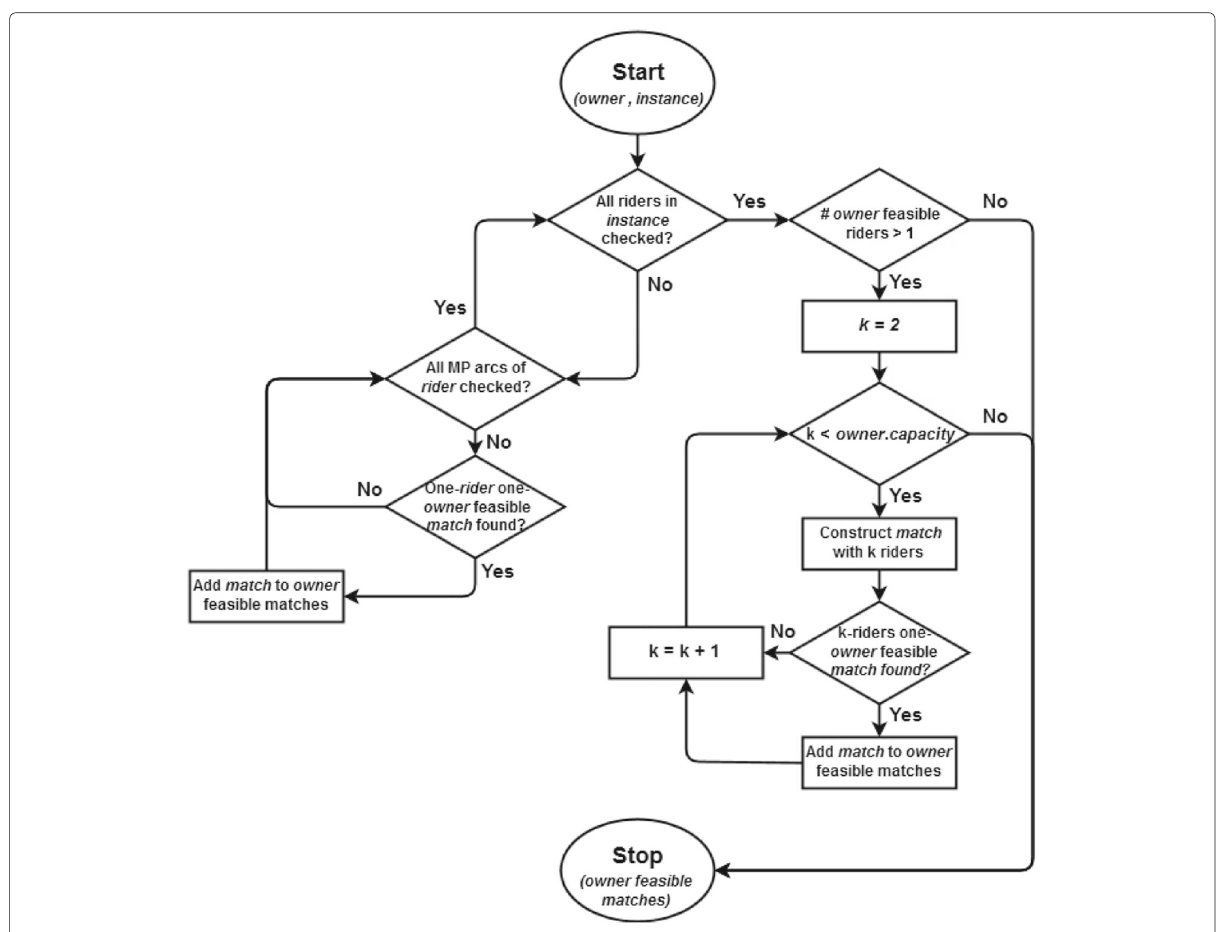
Fig. 4 Algorithm 1 - Find-Owner-Feasible-Matches